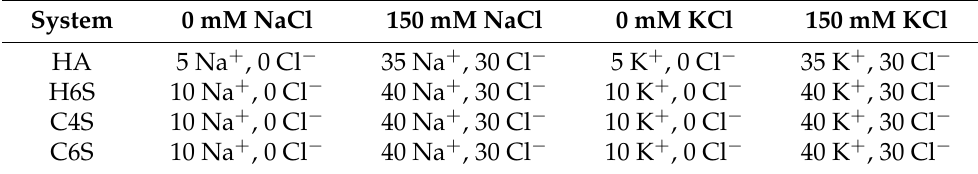
Table 2. Overview of the simulated